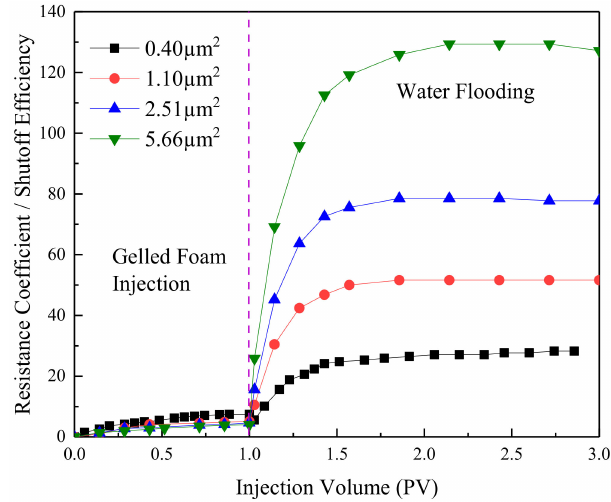
Figure 10. Effect of different permeabilities on the properties of the gelled